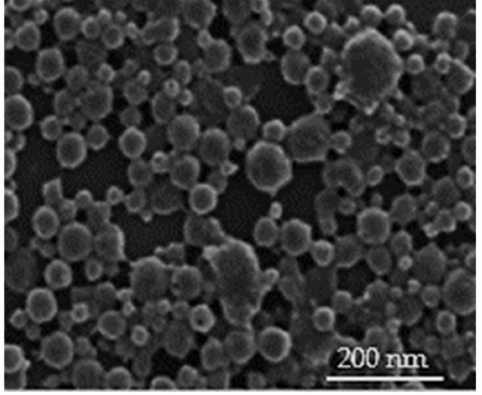
Figure 1. Scanning electron microscopy (SEM) picture of DXL-loaded SF-NPs (magnification ×